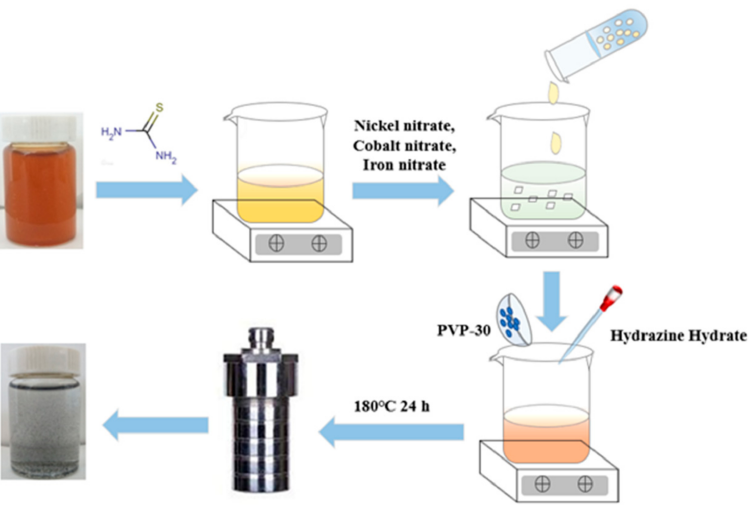
Figure 1. Schematic illustration of the formation process of rGO-NS-M